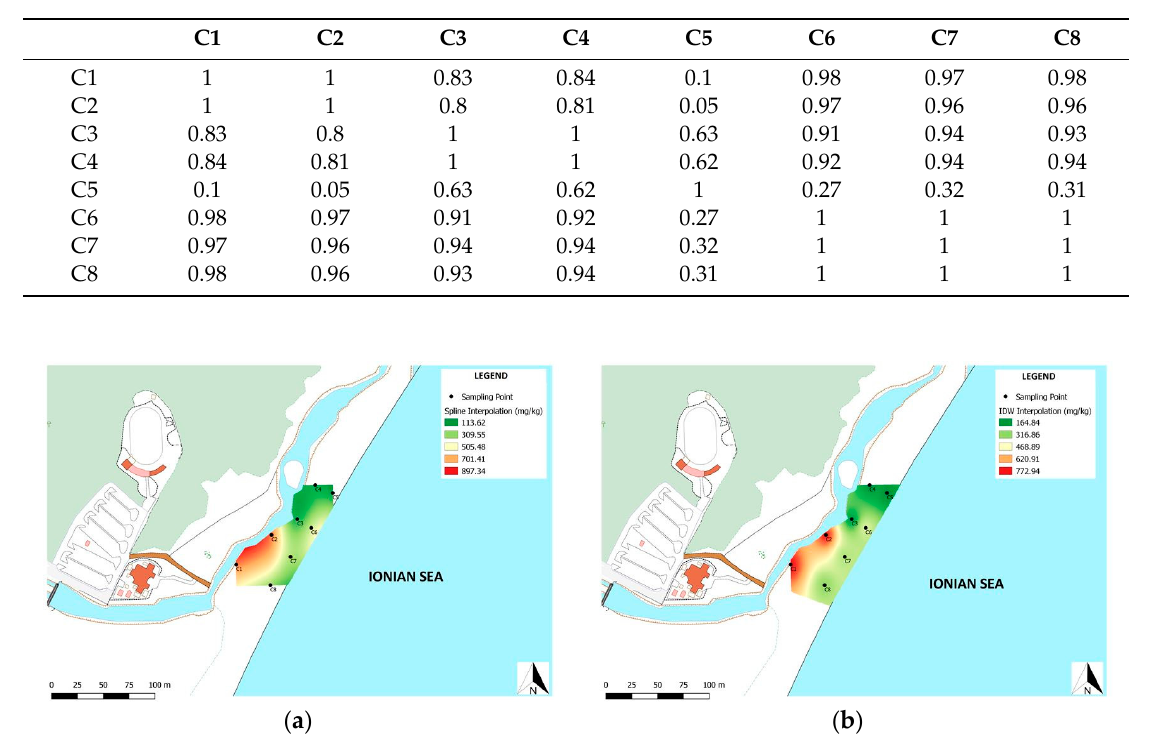
Table 3. Correlation matrix between sampling points.